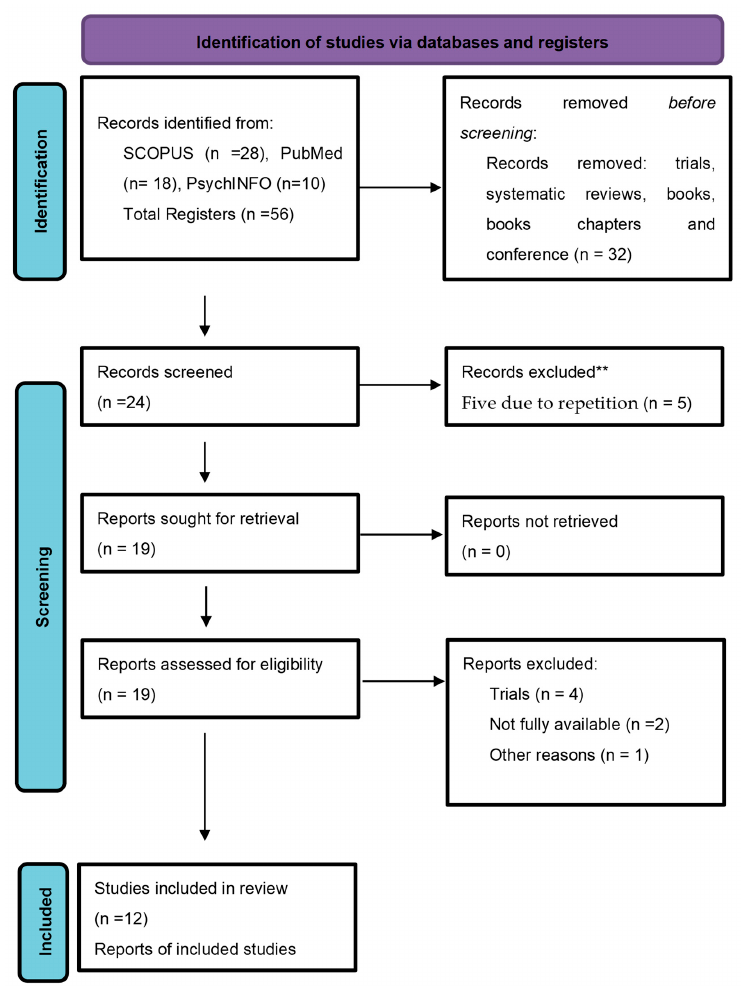
Figure 1. Diagram of the selection of articles. ** In the first reading identical manuscripts were found.